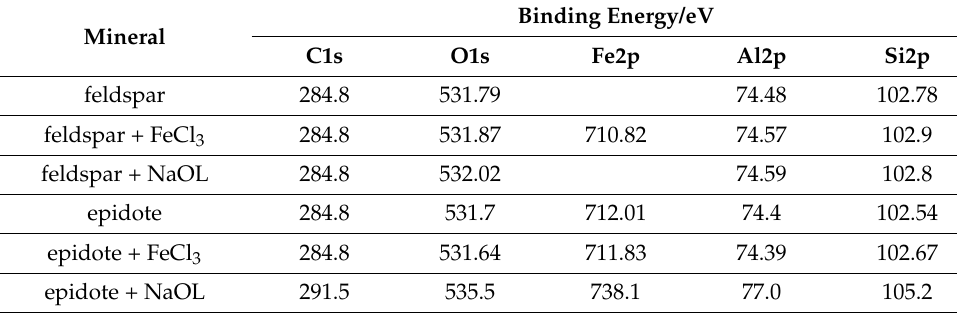
Table 3. Relative Amount of Surface Elements for Minerals.